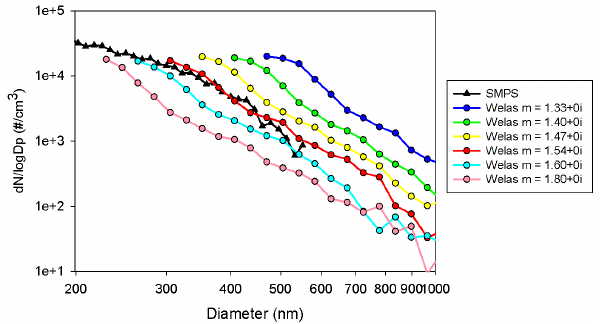
Fig. 6. Mobility size distribution (dark circles) and optical size dis- tributions obtained for different CRI (coloured circles).